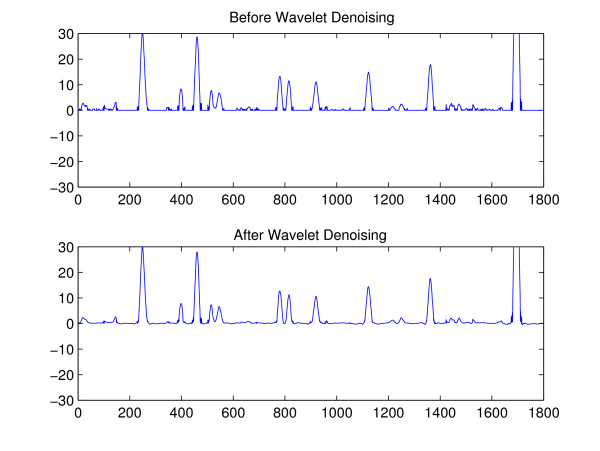
GC data before and after the wavelet-domain denoising. The GC data is already GMF filtered.